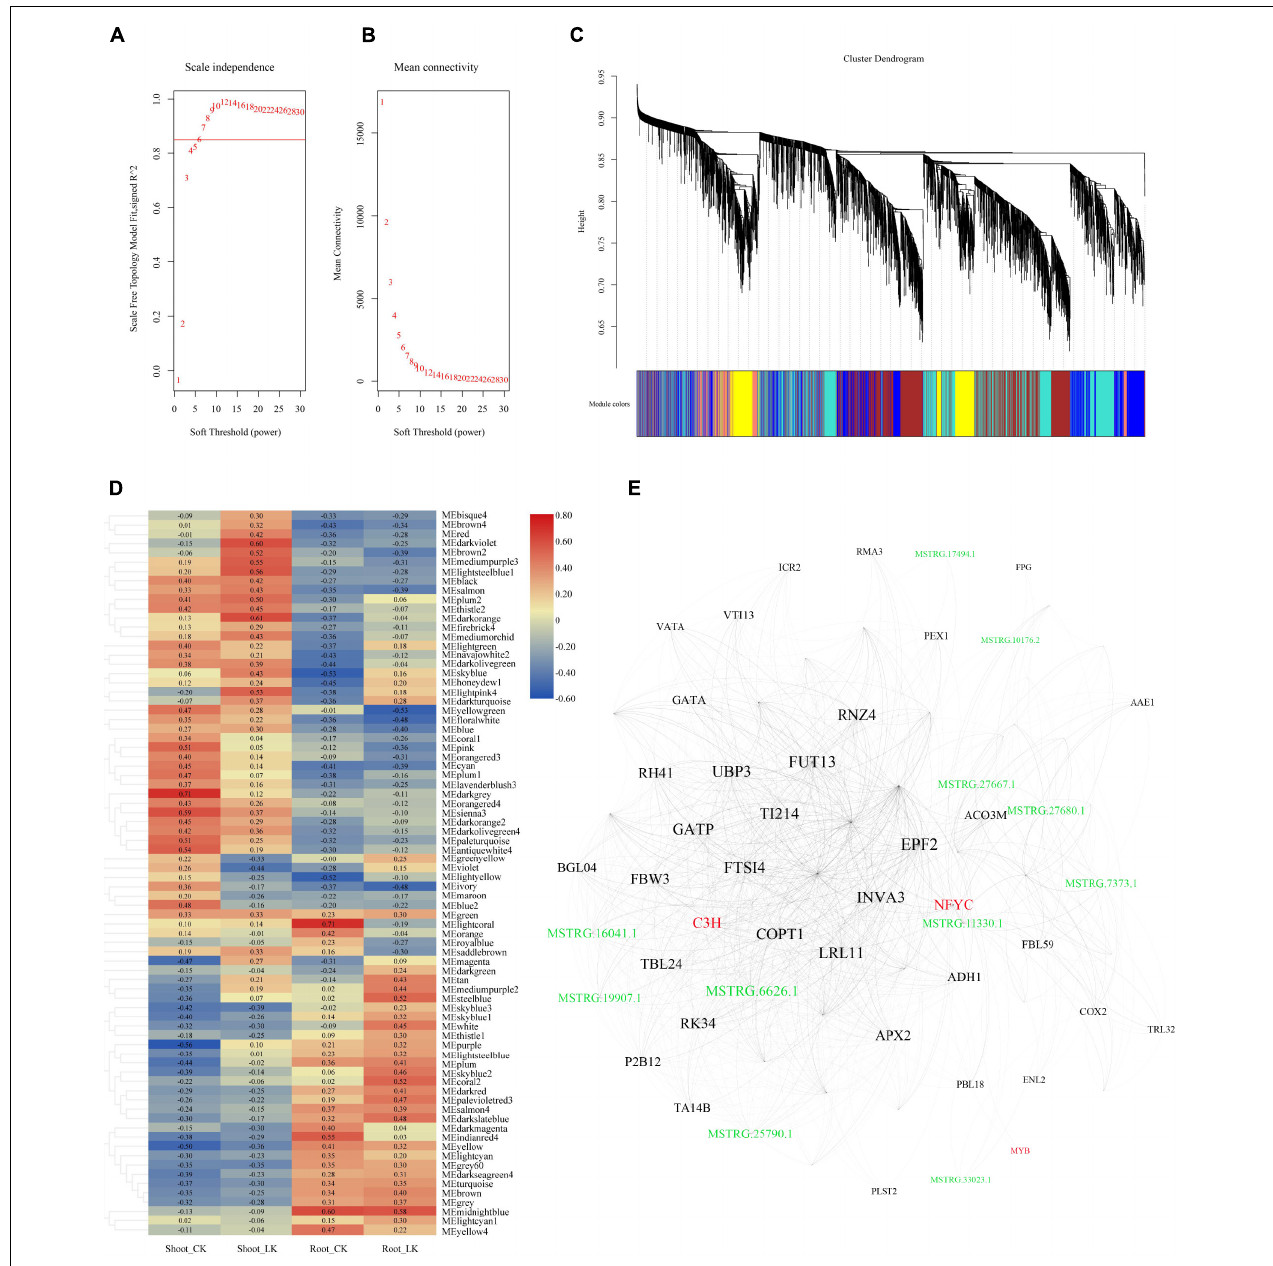
FIGURE 4 | The co-expression network was constructed combined with expressed LncRNAs and coding genes. (A) Analysis of the scale-free fit index for soft-thresholding powers from 1 to 30; (B) analysis of the mean connectivity for soft-thresholding powers from 1 to 30; (C) the clustering dendrogram with dissimilarity based on the topological overlap, together with assigned module colors; (D) the heatmap of correlation between co-expression modules and the treatments; (E) network illustration of co-expression modules associated with low K treatment. The spots represent the node genes, which have high intramodular connectivities. Transcription factors are marked as red, and the spots in green are